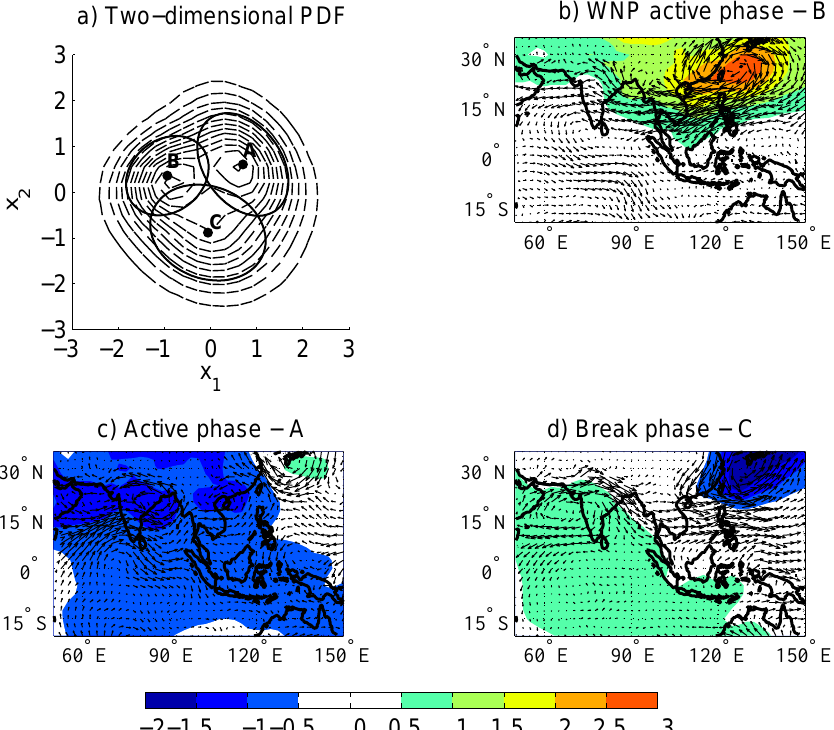
Fig. 11. Three-component Gaussian mixture PDF of the leading two Isomap time series (a) , composites of SLP and 850hPa wind anomalies based on the 300 closest data points to the centres of the mixture PDF for the western North Pacific (b) , the active (c) and the break (d) phases of the ASM. The labels A, B and C in (a) represent, respectively, the active, the WNP and the break phases. Contour interval 0 . 5hPa and the maximum wind speed for the break, active and China Sea active phases are, respectively, 3ms − 1 , 2ms − 1 and 2.3ms − 1 .